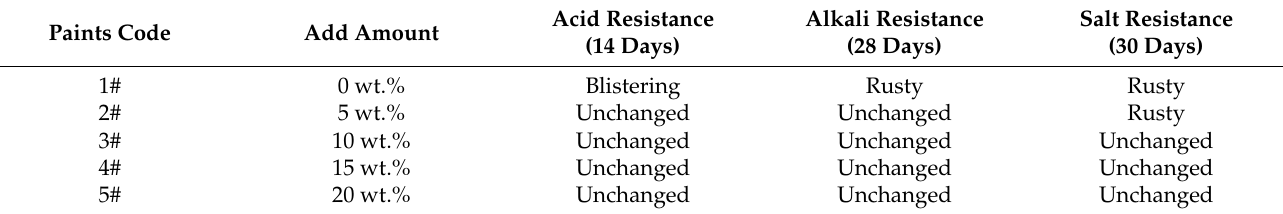
Table 5. The acid resistance, alkali resistance, and salt resistance of different polymer-based coatings. Paints Code Add Amount